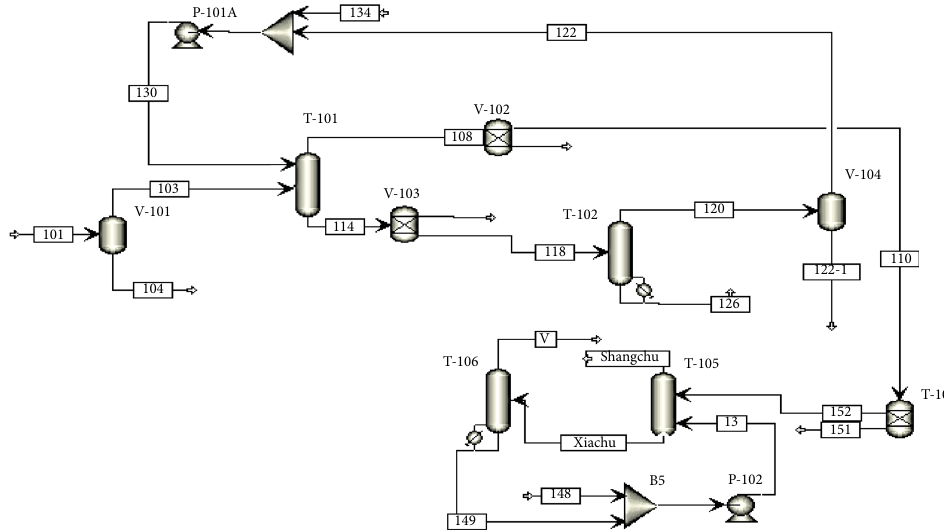
Figure 1: Actual process. Table 2: Puri fi cation results with di ff erent reagents.